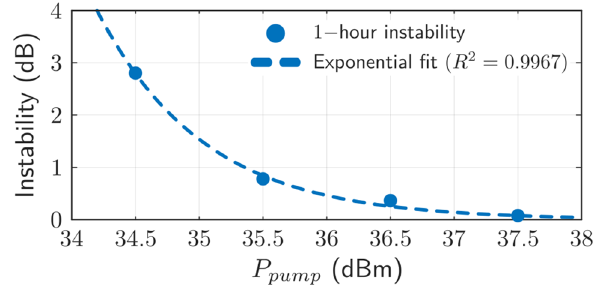
Figure 5. Output power instability as a function of Raman pump power, measured over 1 h with a confidence level of 100%.